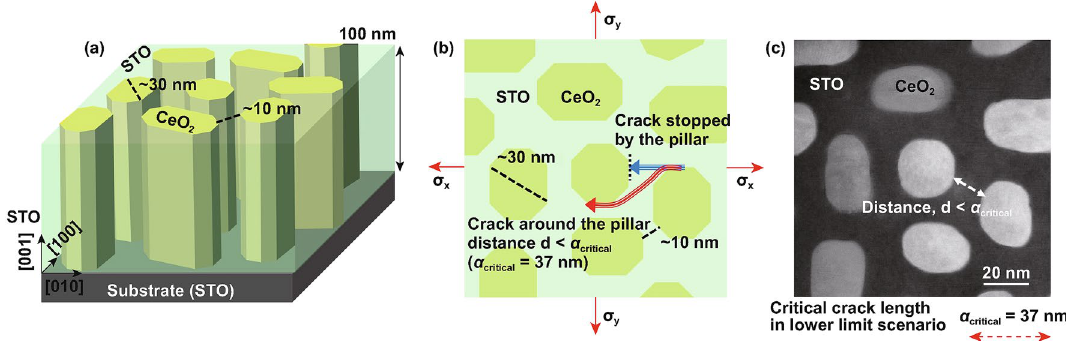
Fig. 5 Schematic diagram of CeO 2 /STO nanocomposite film. a Side view showing the structure of the film. b Top view showing how 2 different cracks might propagate through the STO matrix. In scenario 1, a crack (blue) is stopped at a pillar. In scenario 2, a crack (red) propagates around the pillars. c Real surface scanning transmission electron micrograph of a CeO 2 /STO nanocomposite film. Image adapted from Zhu et al. [70]. (Color figure